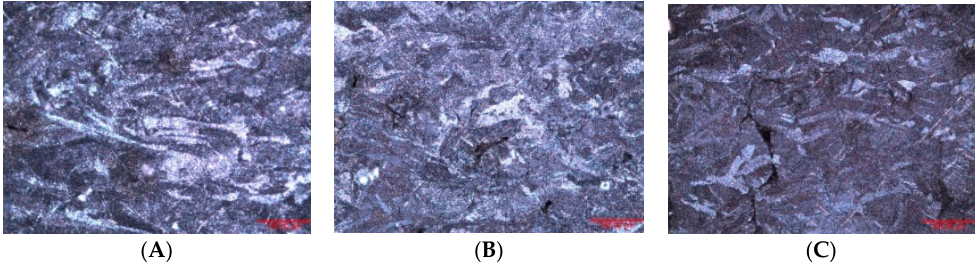
Figure 5. Microstructure of cubes fabricated using parameters ( A ) (200 W); ( B ) (175 W); ( C ) (150 W).